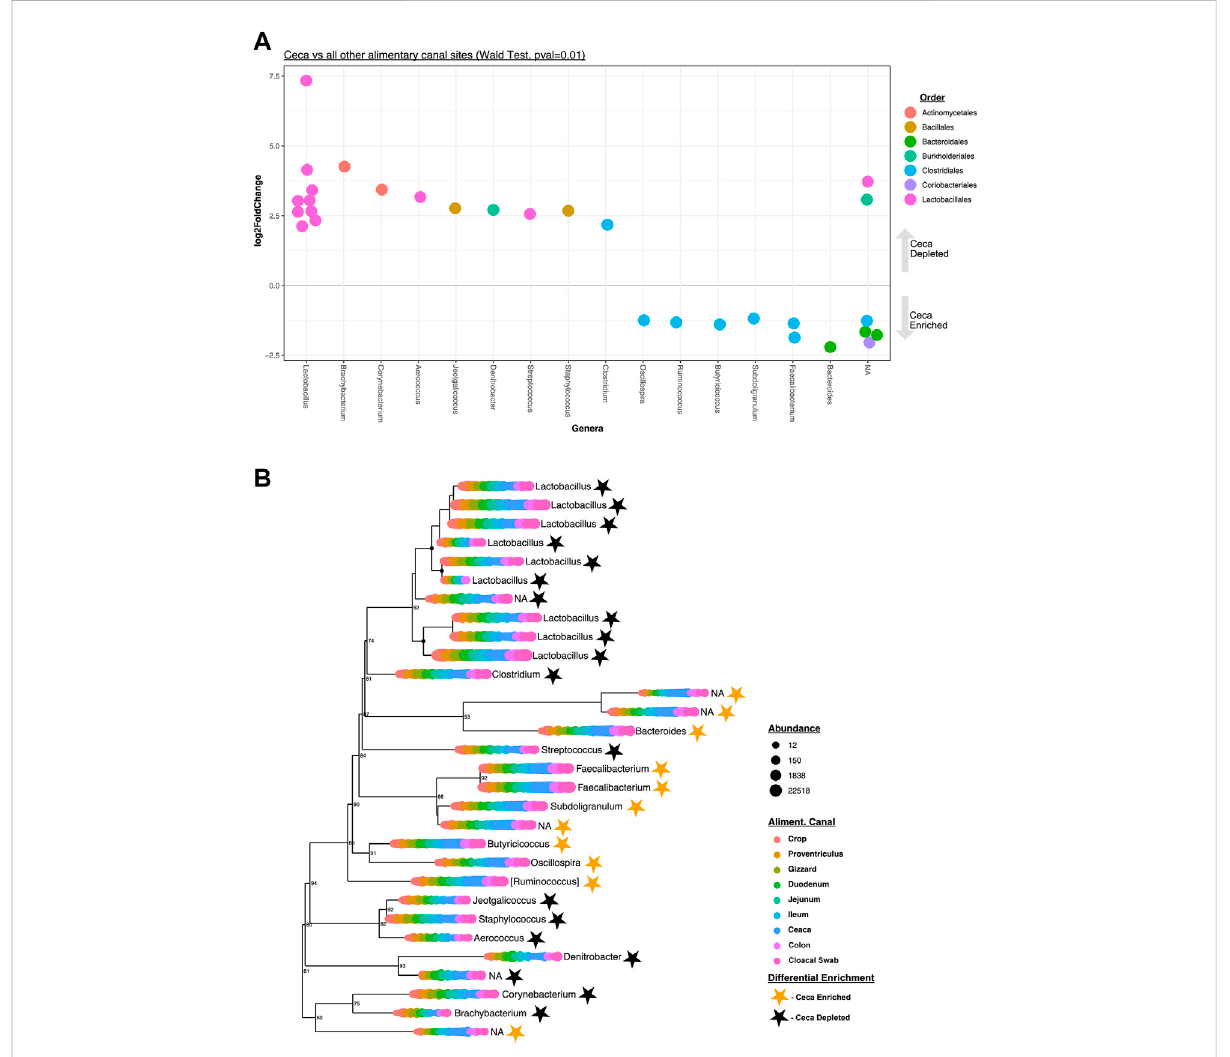
Differentially enriched cecal taxa. (A) Signi fi cantly (Wald Test, Pval = 0.01) differentially enriched cecal taxa ( n = 30). Each circle represents an ASV that was either signi fi cantly enriched (negative LogFold2 values, n = 11) or depleted (positive LogFold2 values, n = 19) in cecal samples. Colored code depicts Order-level taxonomy and columnar arrangement represents Genus-level taxonomy assignments. (B) Phylogenetic tree of the 30 differentially enriched taxa identi fi ed depicted in (A) . The circles at each leaf represent the normalized abundance of each taxon at each color-codedATsite.Thegenus-leveltaxonomyassignmentofeachdifferentiallyenrichedASVisalsoshown.Starsrepresentthestatusofeachtaxon in the tree as either enriched (golden) or depleted (black) in cecal samples relative to all other